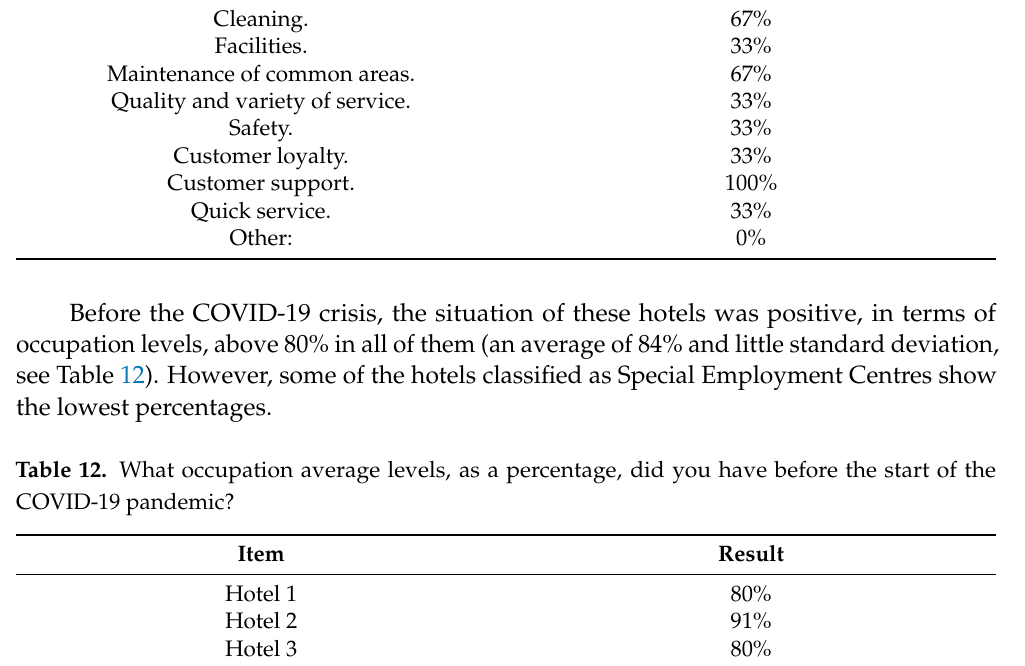
Table 11. What are the best valued aspects to customers? Mark one or more options. Answer Result Cleaning. 67% Facilities. 33% Maintenance of common areas. 67% Quality and variety of service. 33% Safety. 33% Customer loyalty. 33% Customer support. 100% Quick service. 33% Other: 0%